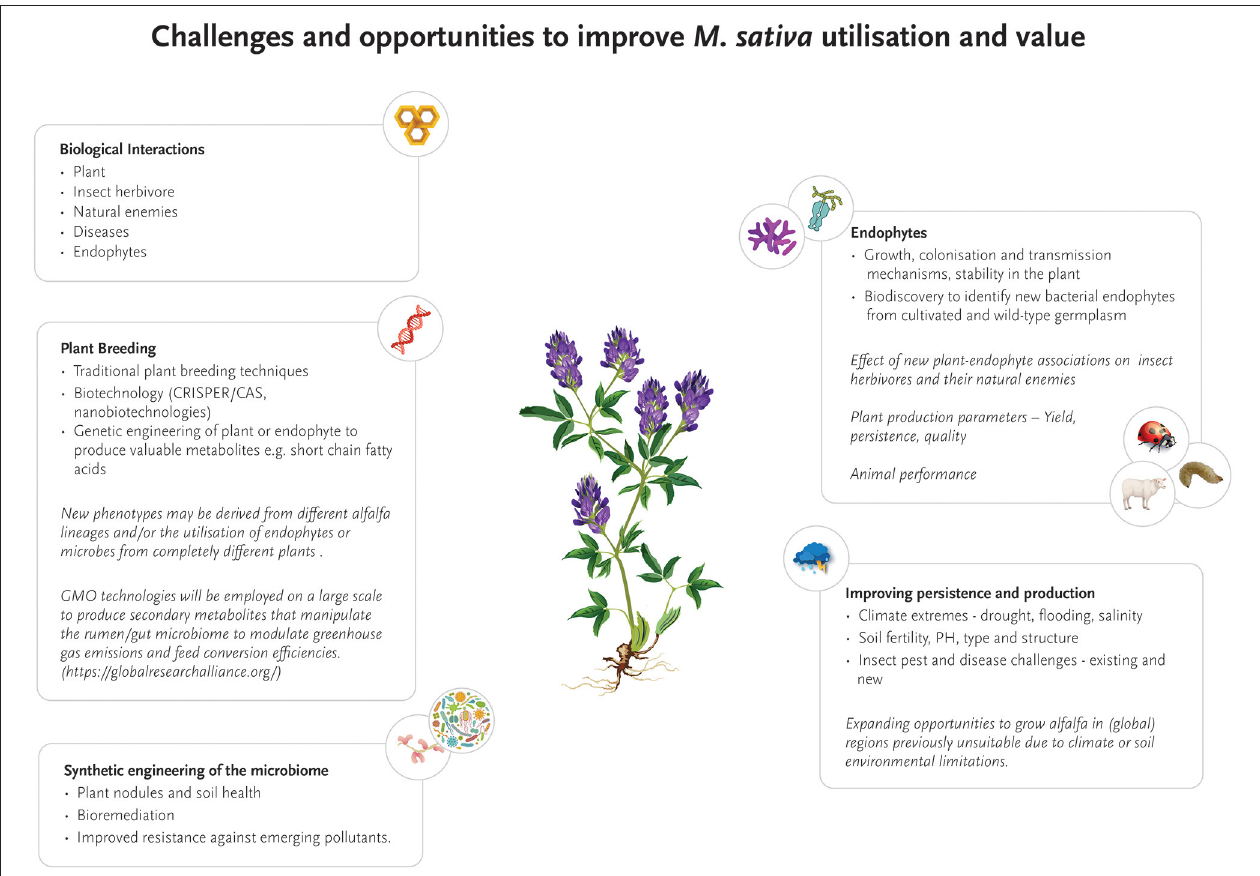
FIGURE 2 | Current and future research opportunities to improve the production, persistence, quality and geographic range of Medicago sativa as a forage